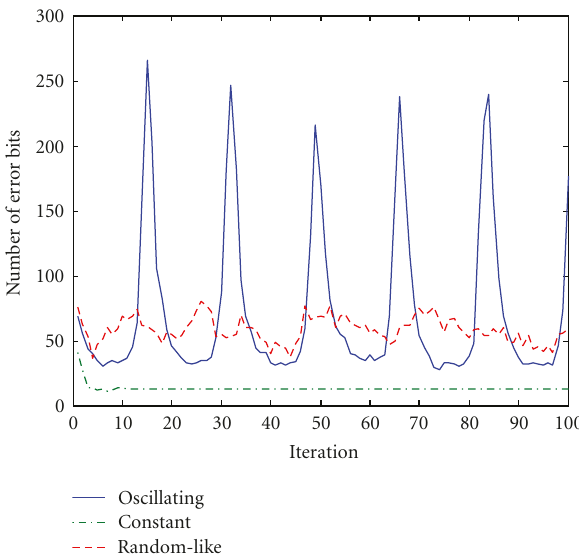
Figure 4: Illustration of the three types of error patterns.